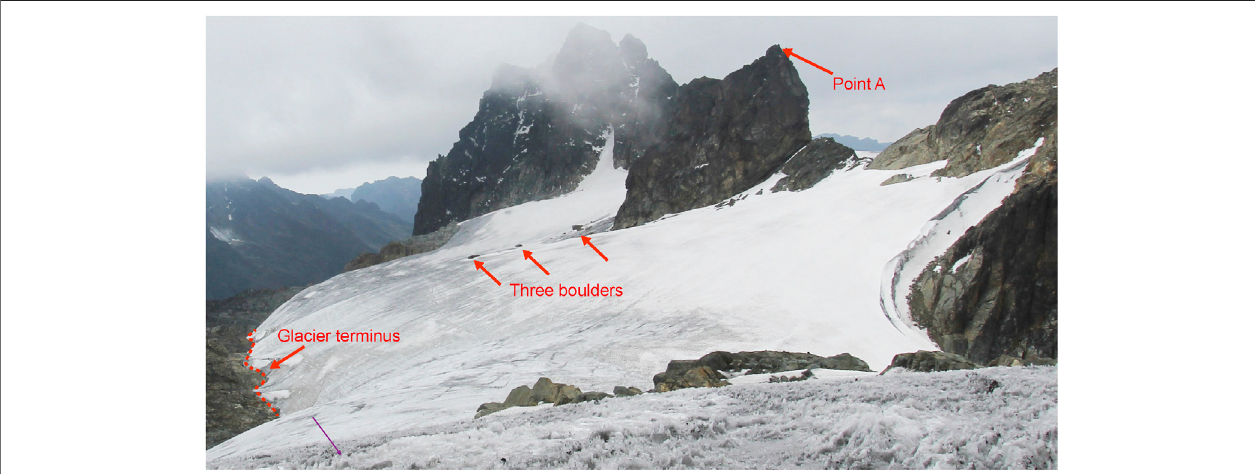
FIGURE 2 | General view of Stanley Glacier, Rwenzori mountains, looking southeastwards, from the 2012-ST3 sampling site ( Figure 3 ). The image was taken in February 2012, 1 month after the Worldview satellite image shown in Figures 1 , 3 . The position and direction of the photo are plotted on the same satellite image ( Figure 3